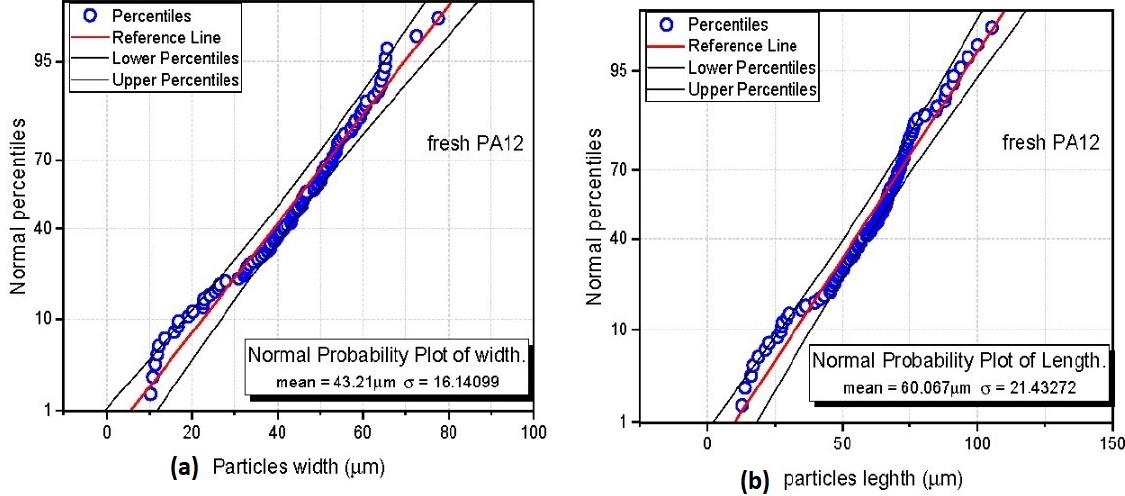
Figure 4. Example of normal probability plots for fresh PA12 sample ( a ) width; ( b ) length measurement.